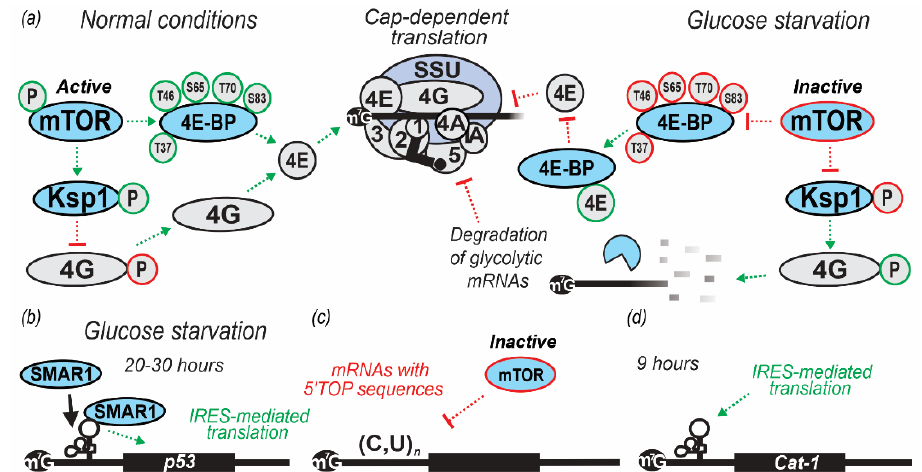
Figure 2. Regulation of translation during glucose starvation stress by targeting ribosomal attachment to mRNA. (a) Under optimal growth (normal) conditions, mTOR constitutively phosphorylates 4E-BP1 (T stands for threonine, S for serine), which prevents 4E-BP1 binding to eIF4E and promotes cap-dependent translation. mTOR also phosphorylates Ksp1, which promotes formation of the eIF4F complex and cap-dependent translation (green). Glucose starvation leads to inactivation of mTOR (red) which results in the accumulation of hypophosphorylated 4E-BP1, which binds eIF4E and inhibits cap-dependent translation. (b) Glucose starvation of H1299 and A549 cells for 20-30 h was shown to induce translation in mRNA-specific manner via IRES in p53 mRNA and SMAR1 ITAF. (c) Inhibition of mTOR strongly impairs (red) translation of mRNAs containing 5'TOP sequences. (d) In mammalian cells, up to 9-h glucose starvation induces IRES-mediated translational upregulation of the CAT1 mRNA. Color coding as in Figure 1.